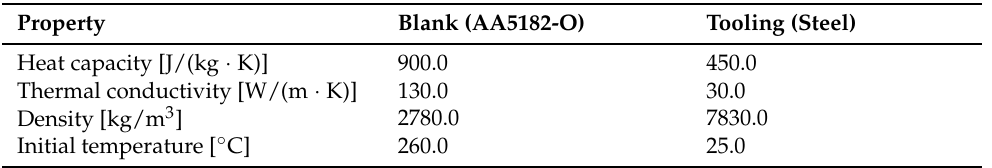
Table 4. Thermal properties of blank and tool used in the FE simulation.